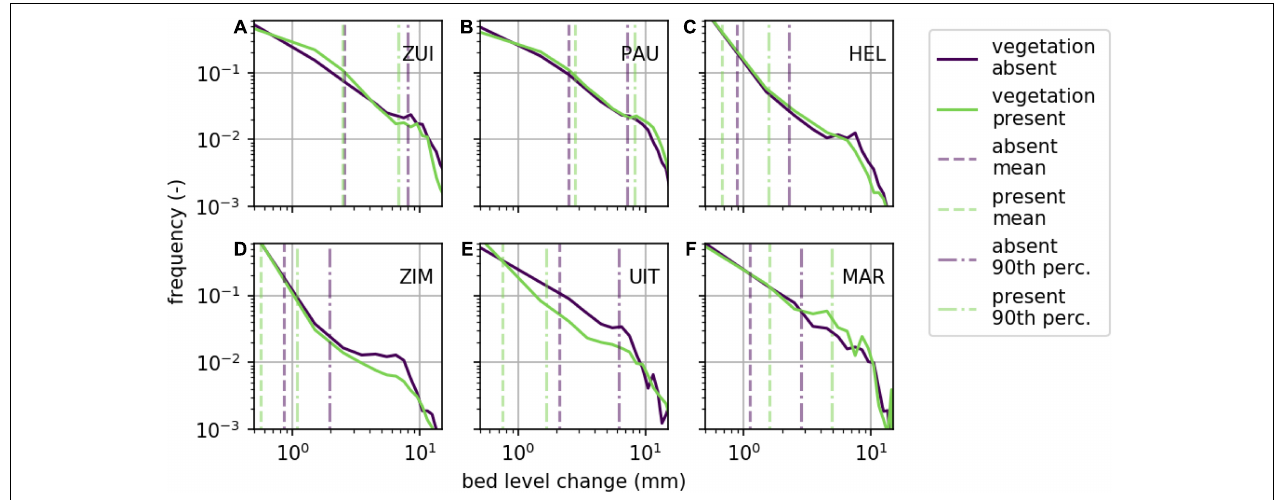
FIGURE 5 | Distribution of bed level change measurements at study sites Zuidgors (A) , Paulina (B) , Hellegat (C) , Zimmerman (D) , Uithuizen (E) , and Marconi (F) . Data are combined for stations where vegetation is present (green) and absent (purple).